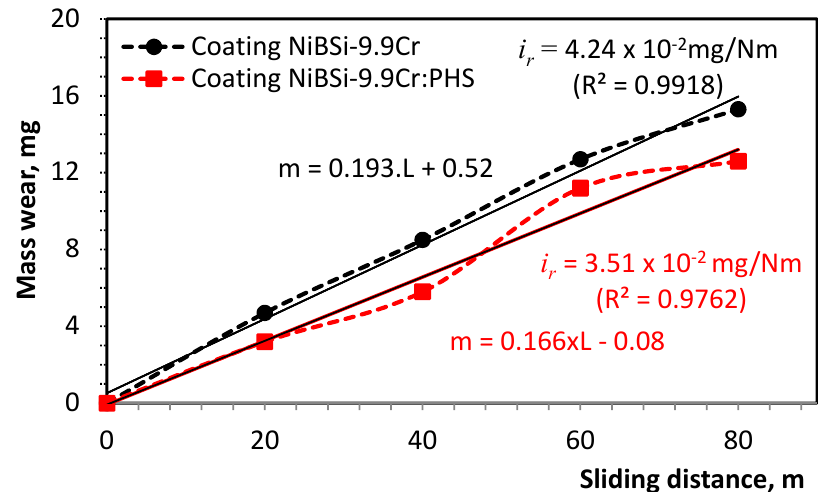
Figure 3. Mass wear vs. sliding distance for NiBSi-9.9Cr and NiBSi-9.9Cr: PHS coatings.